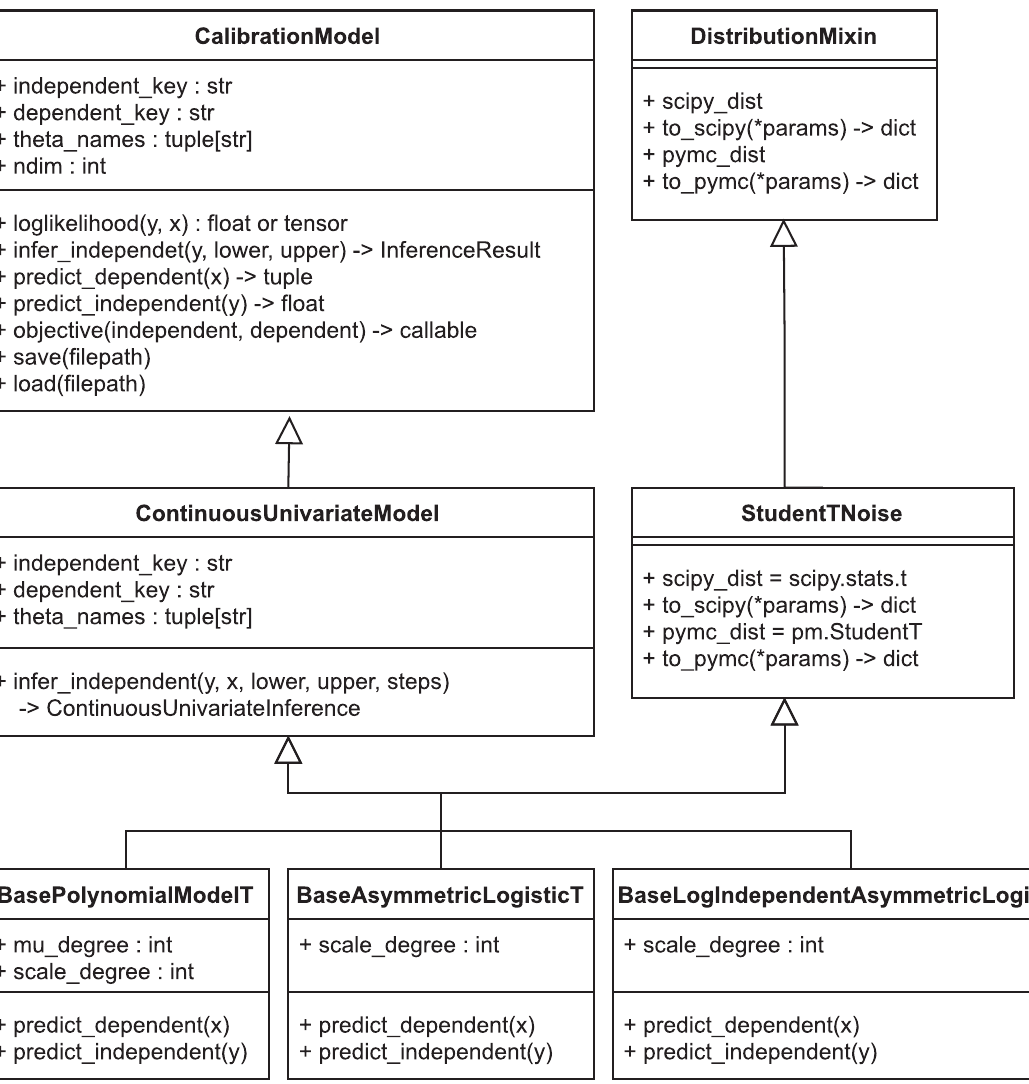
PLOS Computational Biology | https://doi.org/10.1371/journal.pcbi.1009223 March 7,